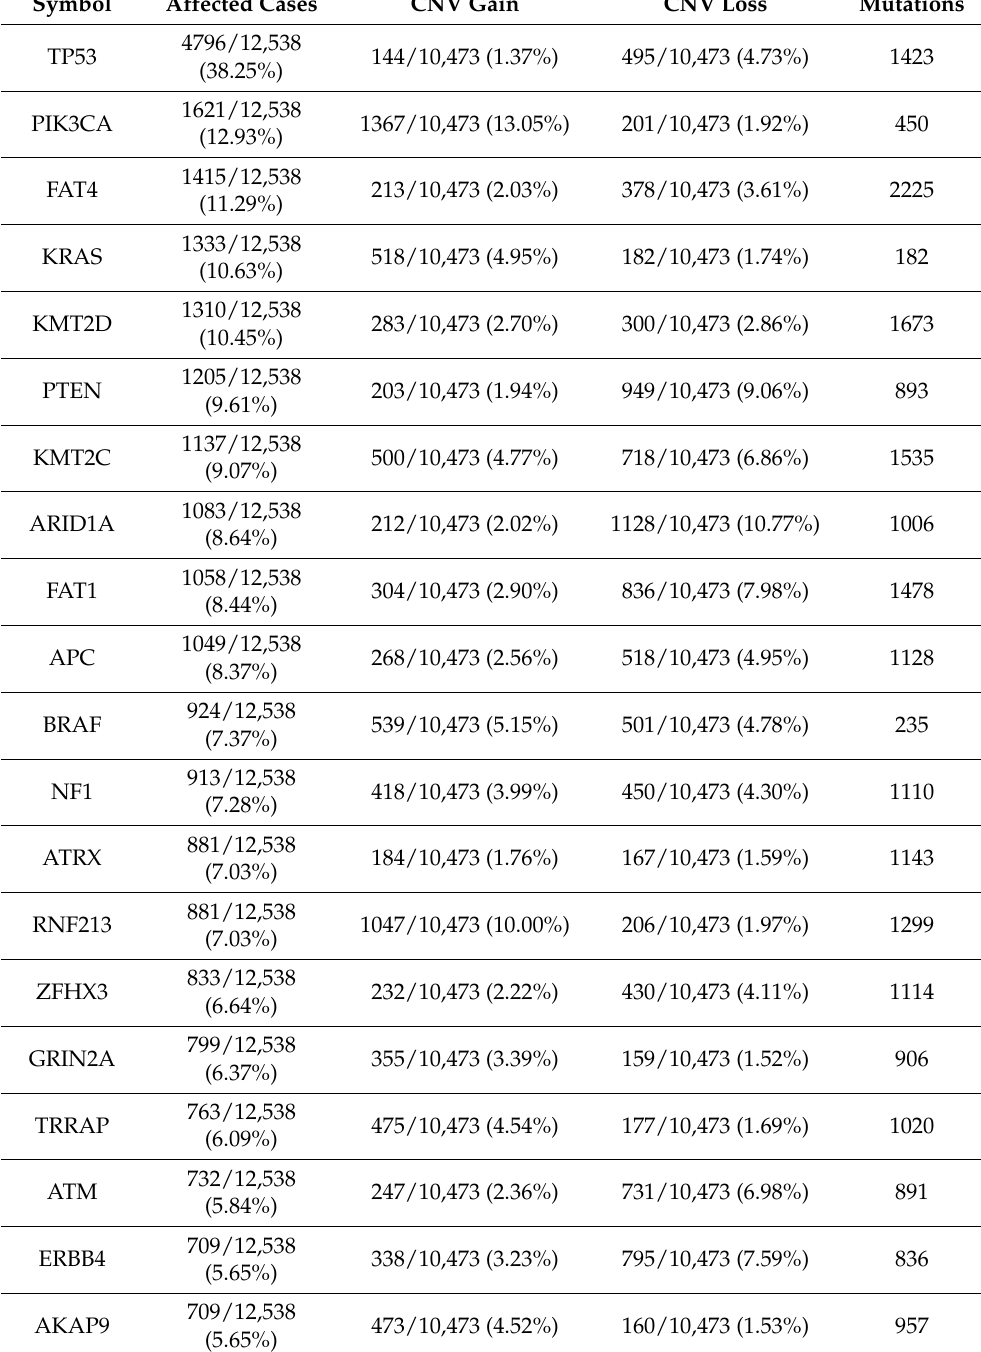
Table 1. The top 20 frequently mutated genes in